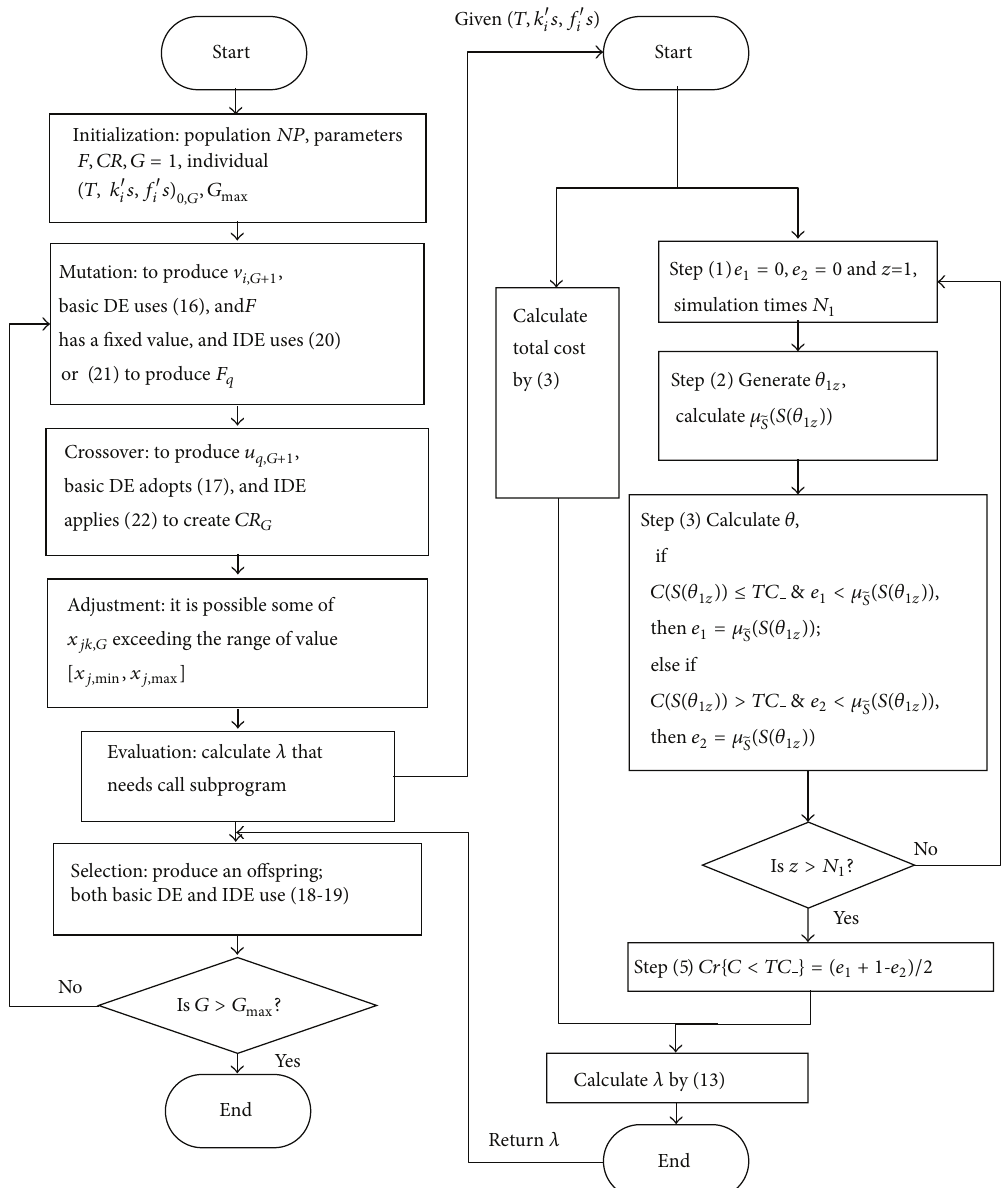
Figure 4: Main flowchart of the proposed algorithm.